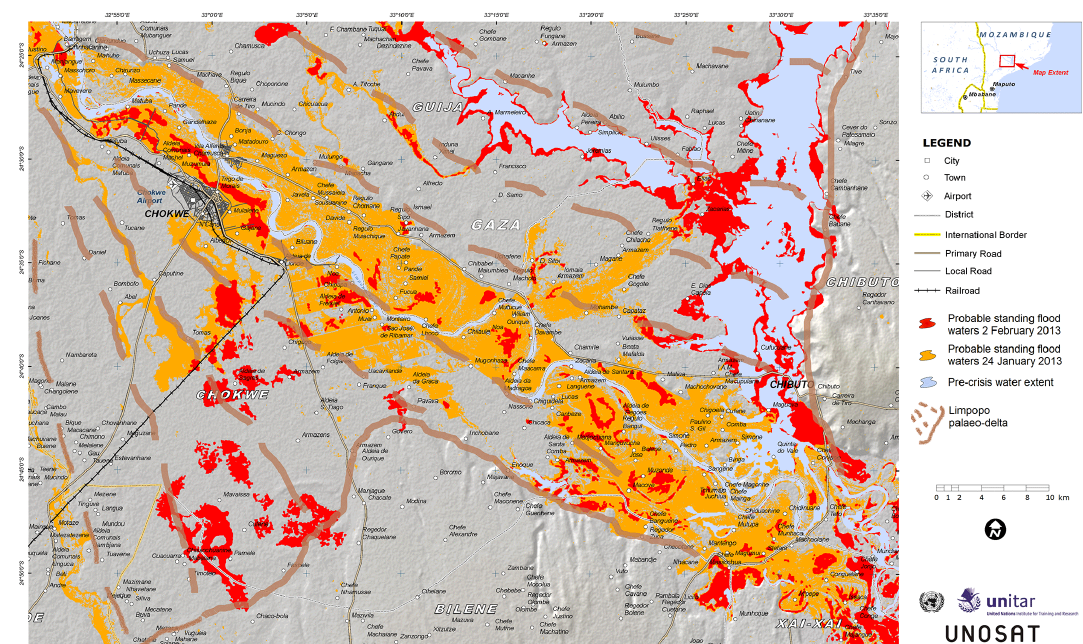
Figure 4. Analysis of the 2013 flood extent in the lower Limpopo River through satellite image interpretation (adapted from http://www. unitar.org/unosat/maps/MOZ, last access 2 February 2013).